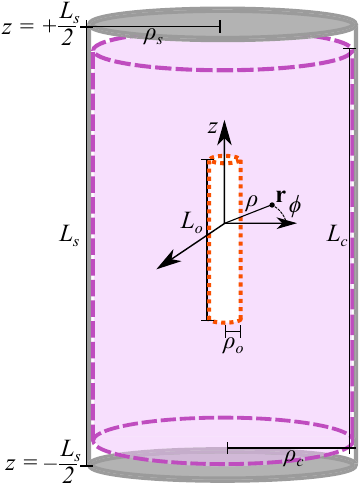
Figure 1. Current flow, J , on a current-carrying coil of radius ρ c and length L c (purple dashed), placed symmetrically inside a co-axial closed cylindrical magnetic shield of radius ρ s and length L s (grey solid), contributes to an optimal magnetic field profile in a cylindrical optimisation region of radius ρ o and length L o (red dotted). The position, r , is displayed in cylindrical coordinates, (ρ , φ , z )